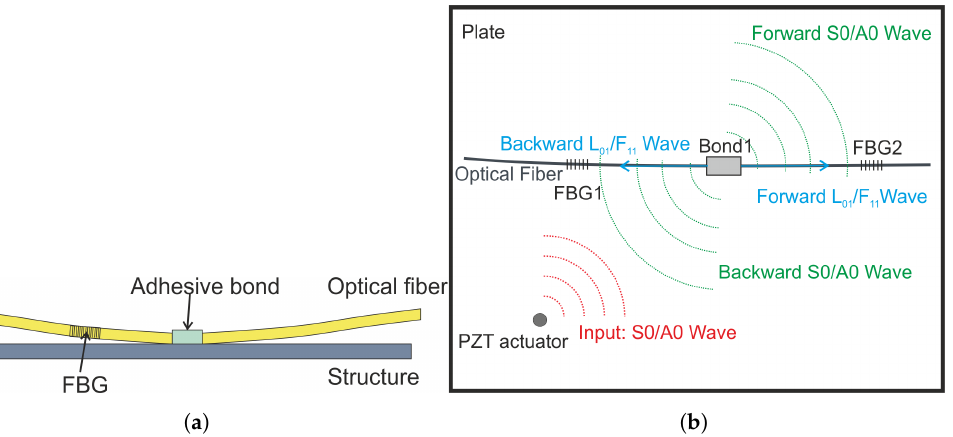
Figure 1. ( a ) Remote bonding configuration ( b ) Mode conversion in remotely bonded